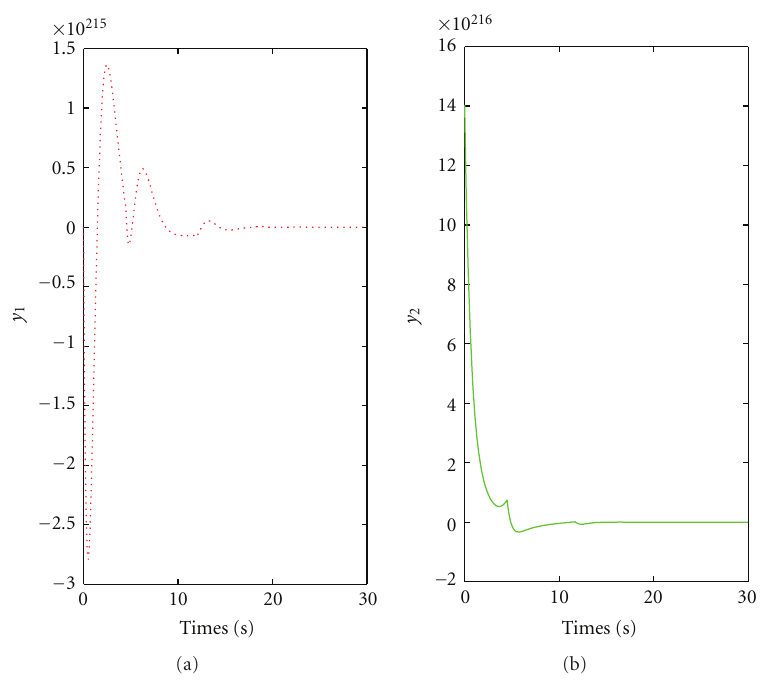
√ 2 /π ) e − (1 / 2) s 2 , s ∈ ( −∞